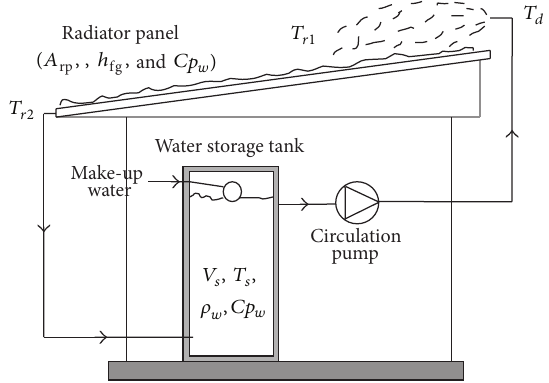
Figure 1: Experimental setup for the radiative cooling measurement systems-radiator panel with